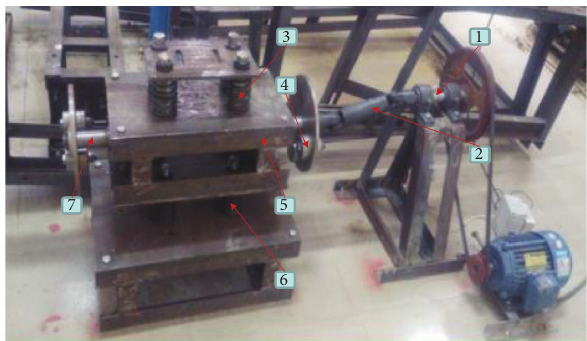
Figure 2: The SSFE. 1: the shorter axis; 2: the axis coupler; 3: upper springs; 4: an eccentric mass block; 5: the middle support platform; 6: lower springs; 7: the longer